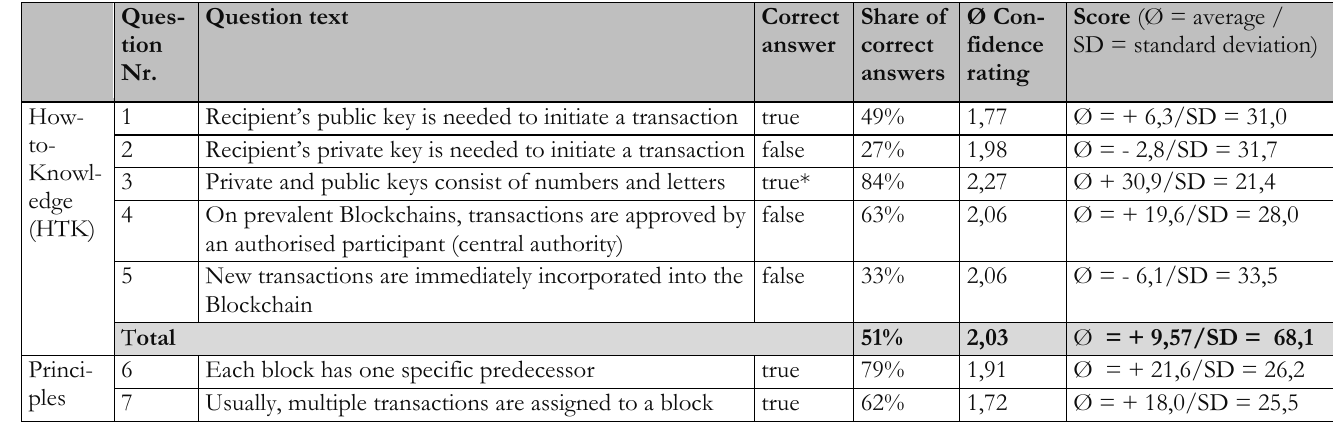
Table 5. Blockchain-quiz – questions and